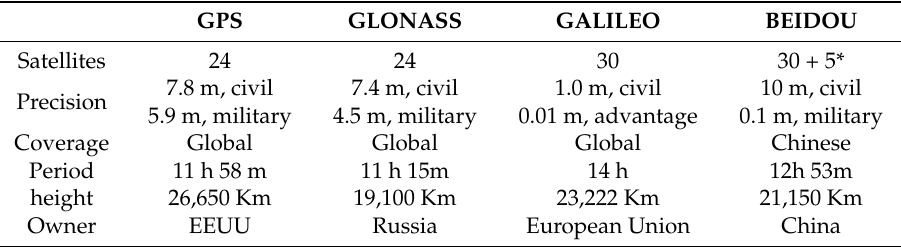
Table 2. Most commonly used global positioning